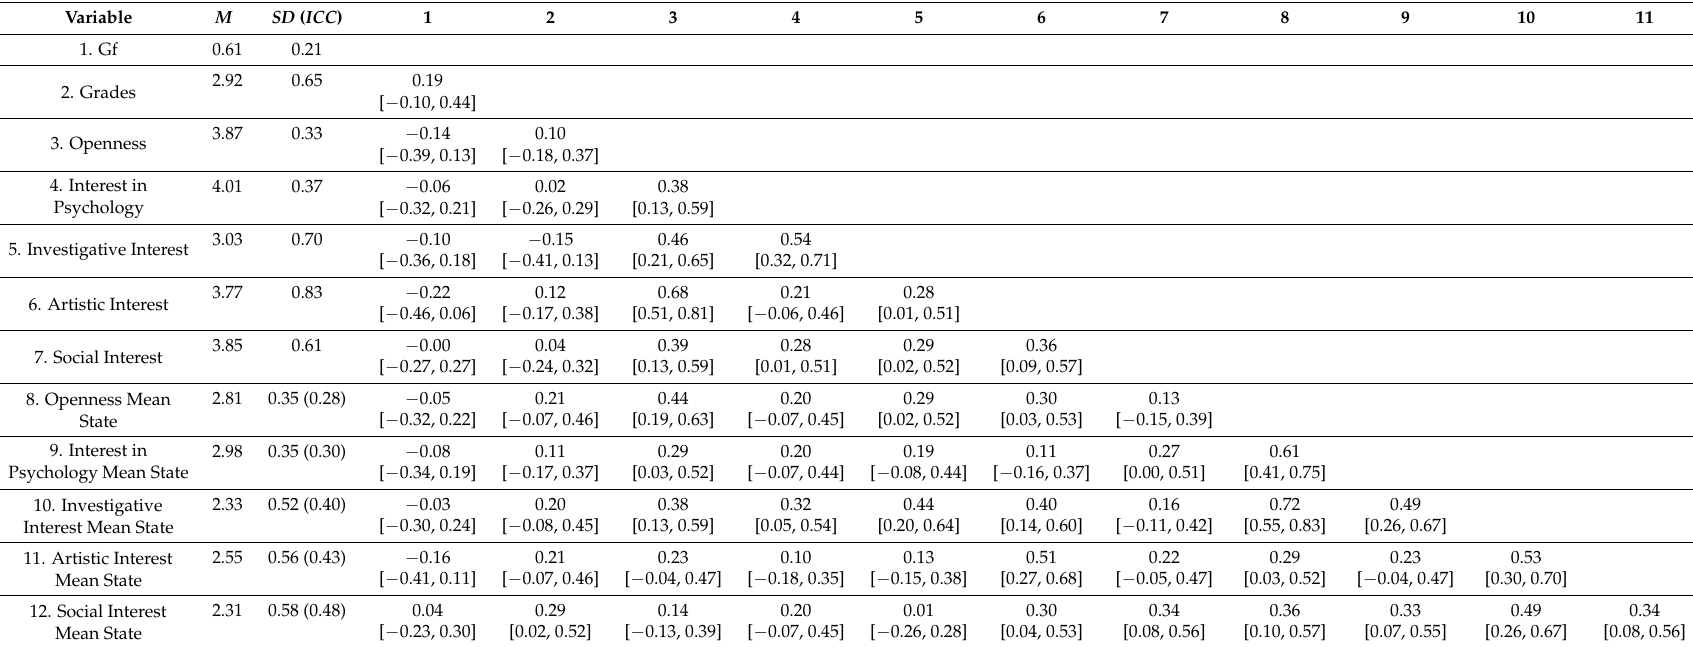
Table 1. Means, standard deviations, and correlations with confidence